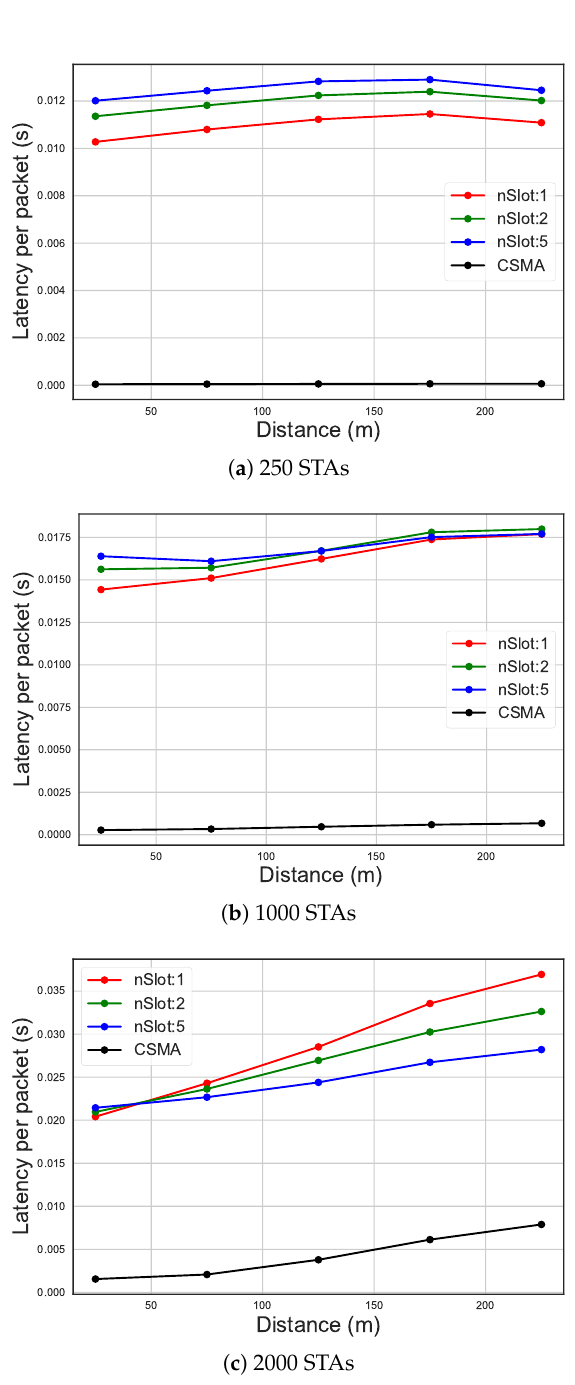
Figure 13. Latency on distance, comparing CSMA/CA and the usage of 10 RAW groups and one, two and five slots per group, using 30 s as average packet arrival